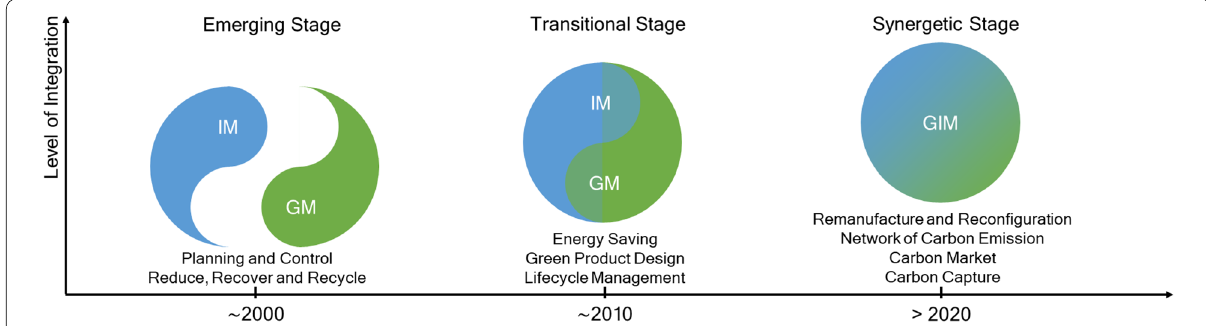
Figure 1 Evolution of greentelligent manufacturing. IM: intelligent manufacturing; GM: green manufacturing; GIM: greentelligent